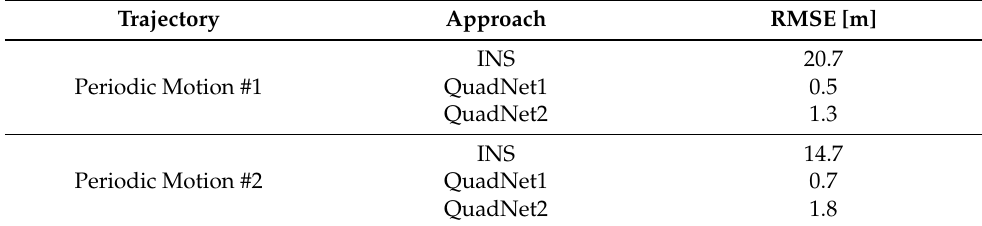
Table 3. INS and QuadNet height RMSE using IMU #1 readings.